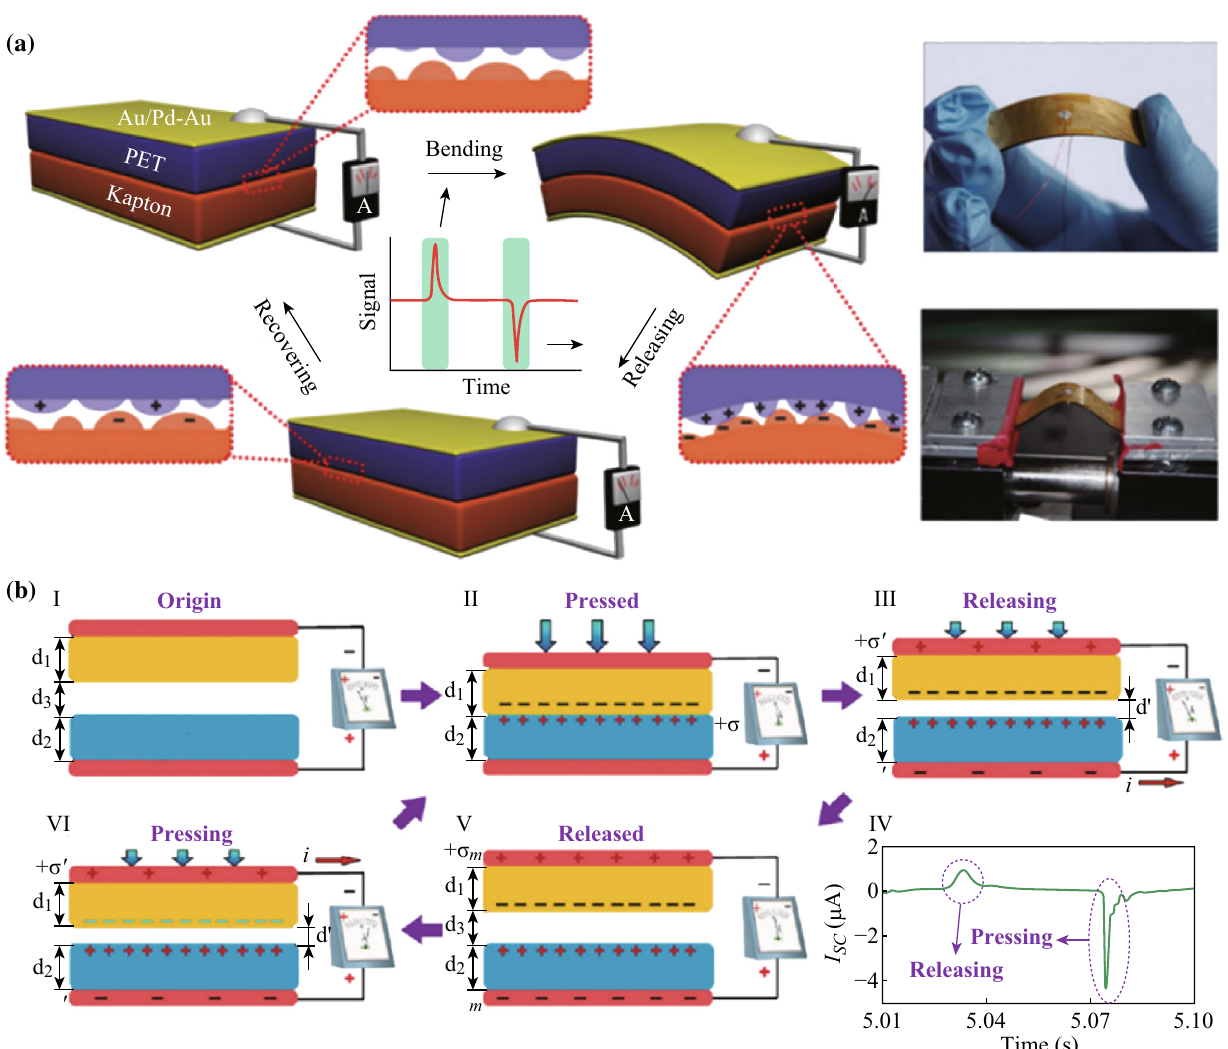
Fig. 7 Invention and working principle of the first TENG that converts mechanical energy into electricity. a The construction and photography images in bending and releasing process and related electrical measurement tests. b Sketches that illustrate the operating principle. Figures adapted from [11,